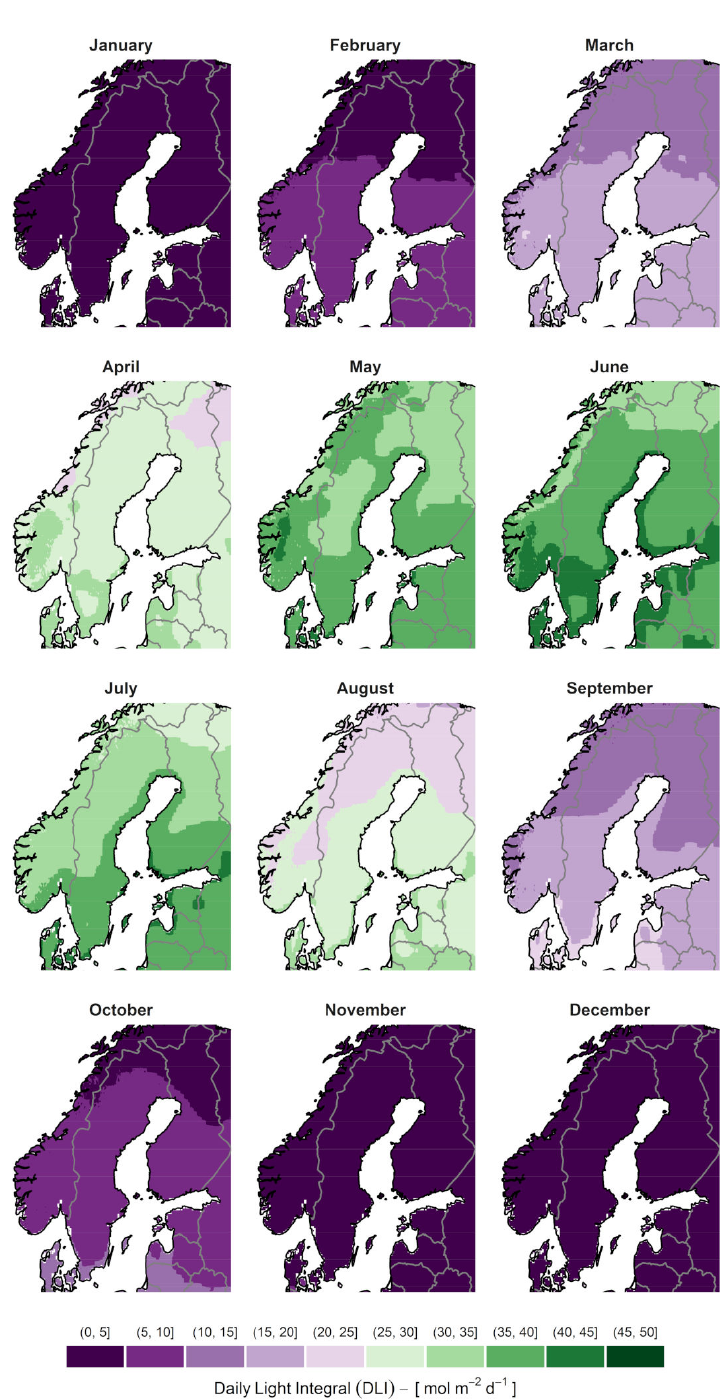
Figure 3. Monthly average photosynthetic daily light integral (DLI sun , mol · m − 2 · d − 1 ) maps for the Nordic and Baltic countries. Values from the ECMWF-ERA-5 dataset with a coverage period of 2005–2016 retrieved from PVGIS as a 0.1 ◦ × 0.1 ◦ grid both in latitude and longitude, extending from 54.5 ◦ N to 70 ◦ N in latitude and 4.5 ◦ E to 31.5 ◦ E in